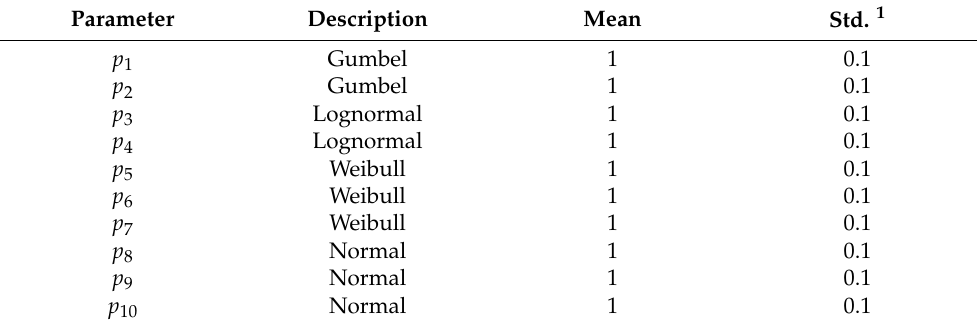
Table 2. Description of parametric uncertainties in Example